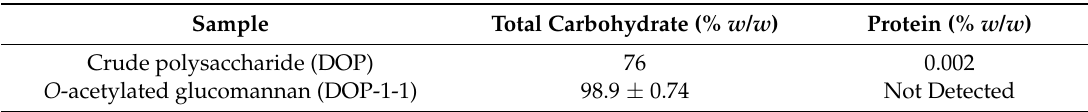
Carbohydrate and Protein Contents of Crude polysaccharide and purified O -acetylated